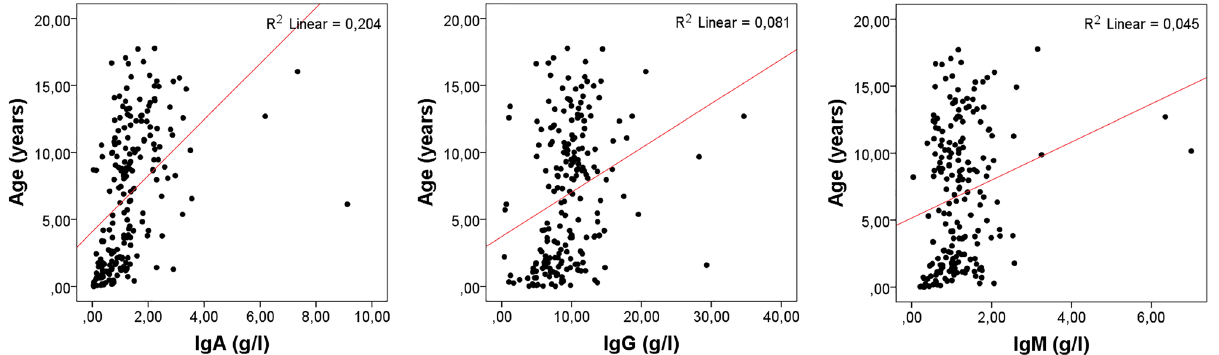
Figure 1. Plot of IgA, IgG, and IgM levels (g/l) against age (years) a Acromion n = 1; clavicle n = 5; scapula n = 1 b Fingers n = 4; metacarpal bones n = 2 c Cuboid n = 1; cuneiform n = 2; navicular n = 1. d Metatarsal bones n = 6; toes n =